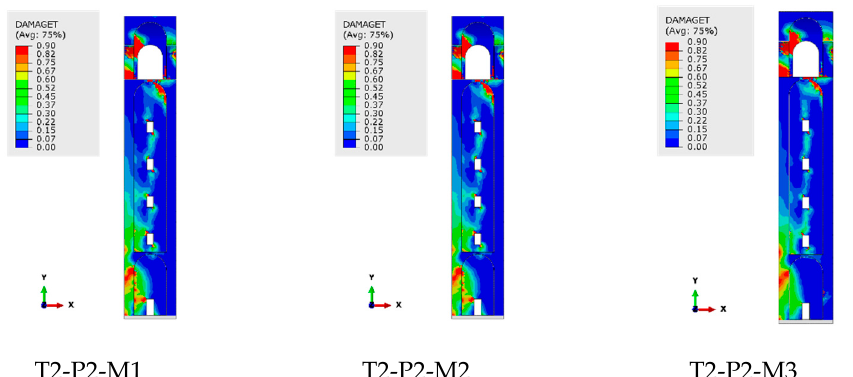
Figure 10. Damage patterns of tower T2 subjected to a displacement at the top, i.e., the load pattern P2 for three different materials, from left to right MI to M2 and M3 respectively.